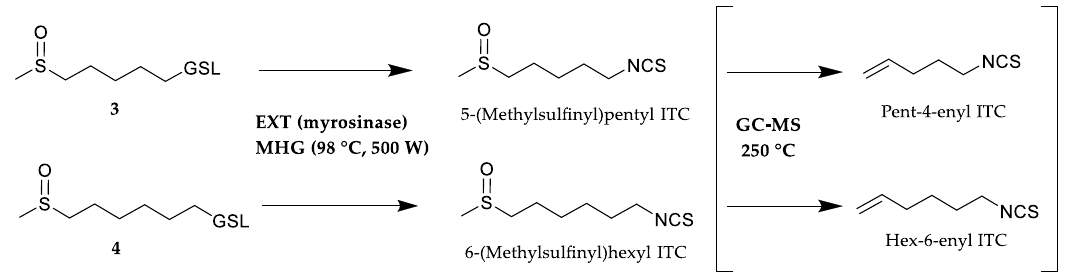
Figure 3. Degradation of 5-(methylsulfinyl)pentyl GSL ( 3 ) and 6-(methylsulfinyl)hexyl GSL ( 4 ) to methylsulfinylalkyl isothiocyanates (ITCs) products present in CH 2 Cl 2 extraction after myrosinase hydrolysis (EXT) and microwave hydrodiffusion and gravity (MHG) and their thermolysis products during GC-MS analysis (not present in EXT and MHG).